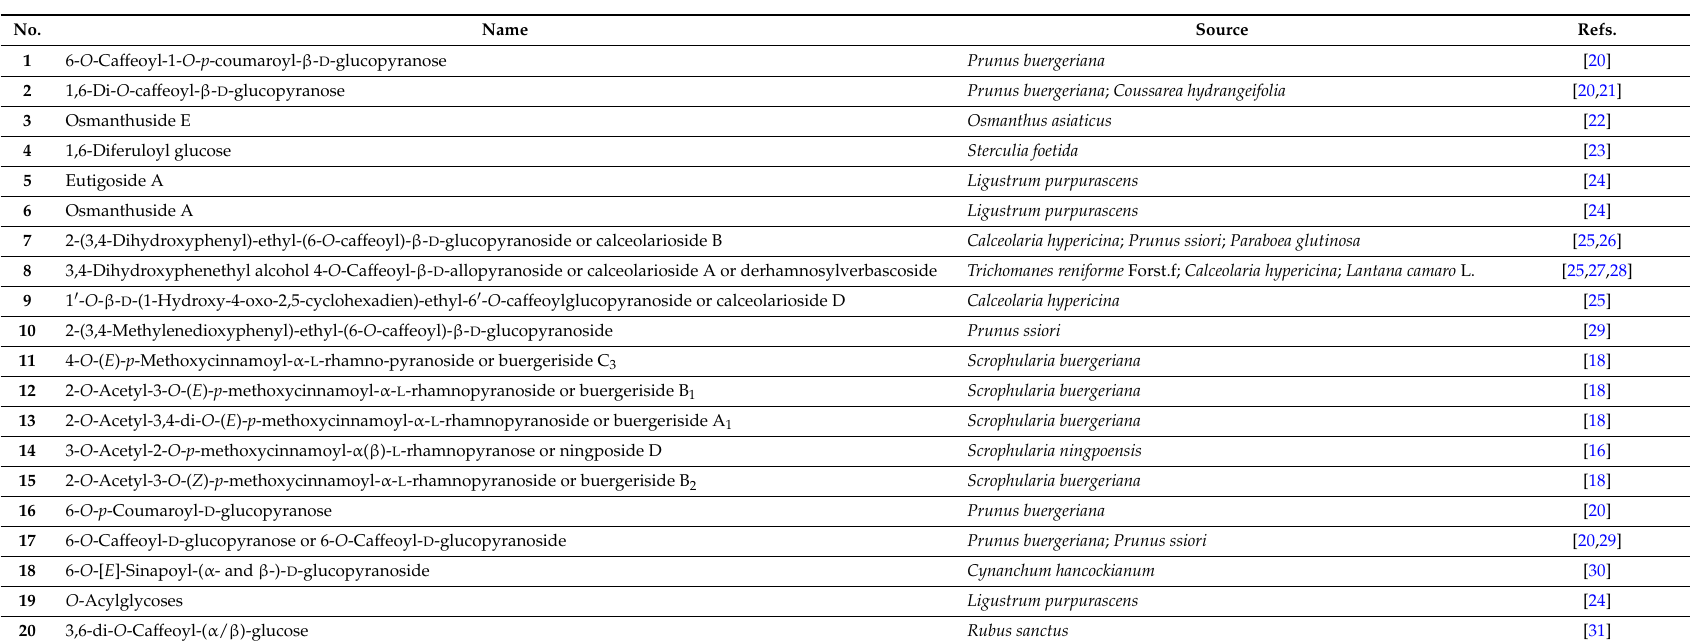
Table 3. Cinnamic Acid Sugar Ester